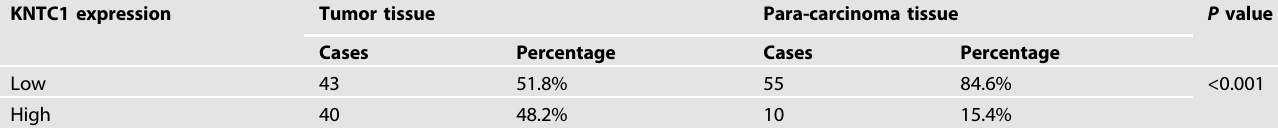
Table 1. Expression patterns of KNTC1 in NSCLC tissues and para-carcinoma tissues were revealed in immunohistochemistry analysis.